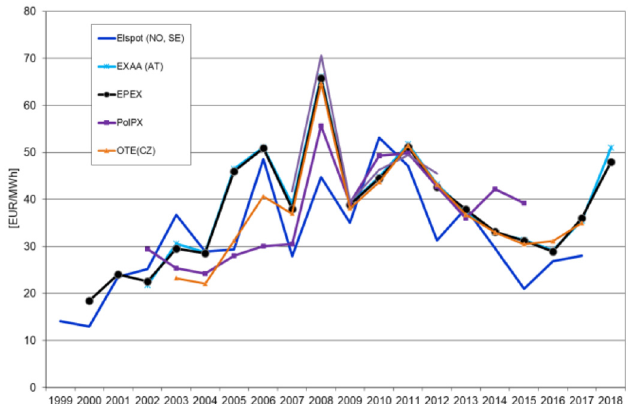
Fig. 3. Development of wholesale electricity prices on various European spot markets (day-ahead) (from 1999